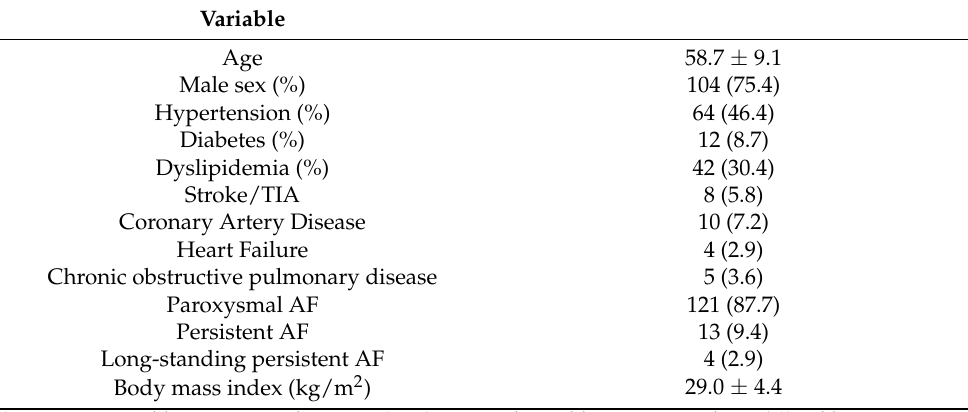
Table 2. Baseline patient